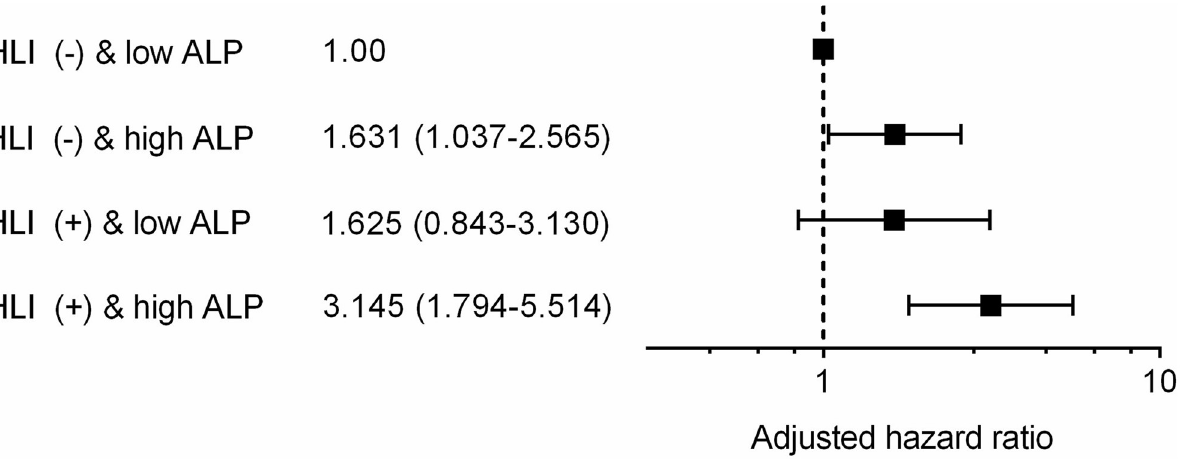
Fig 2. Predictive value of risk groups defined by combination of hypoxic liver injury (HLI) and serum alkaline phosphatase (ALP) level.